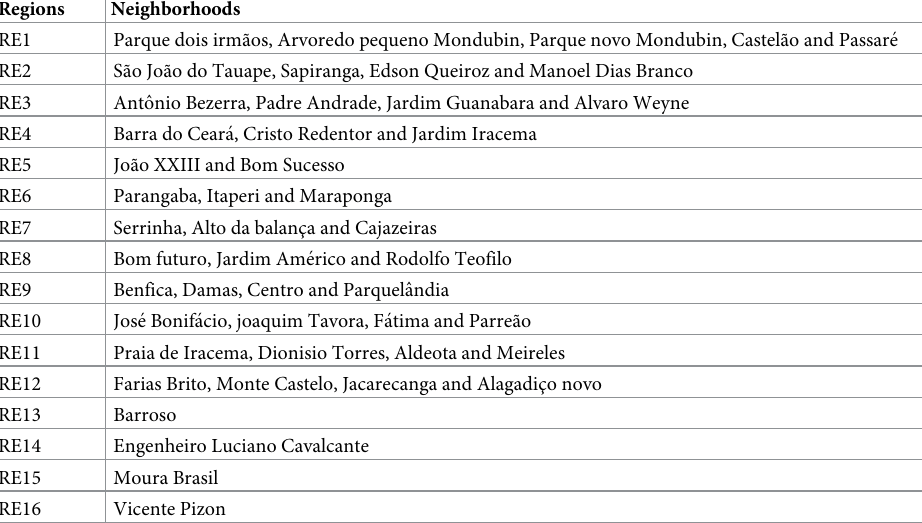
Table 2. Descriptions of the regions and their respective neighborhoods used in the proposed model.